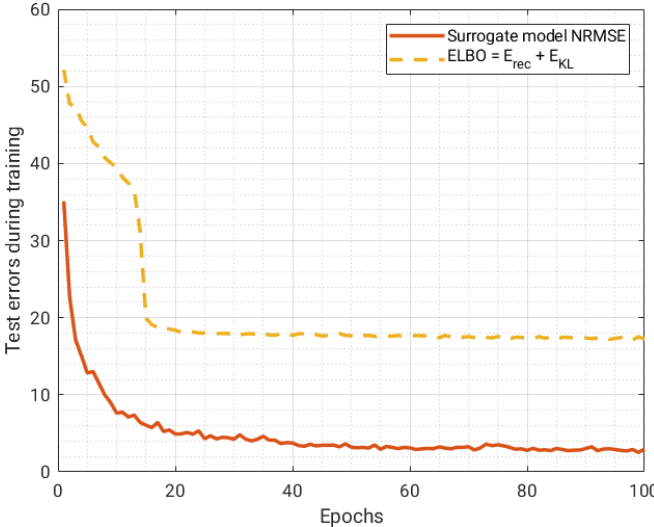
Figure 7. Trend of the test errors during training. No overfitting can be observed, thanks to im- plicit